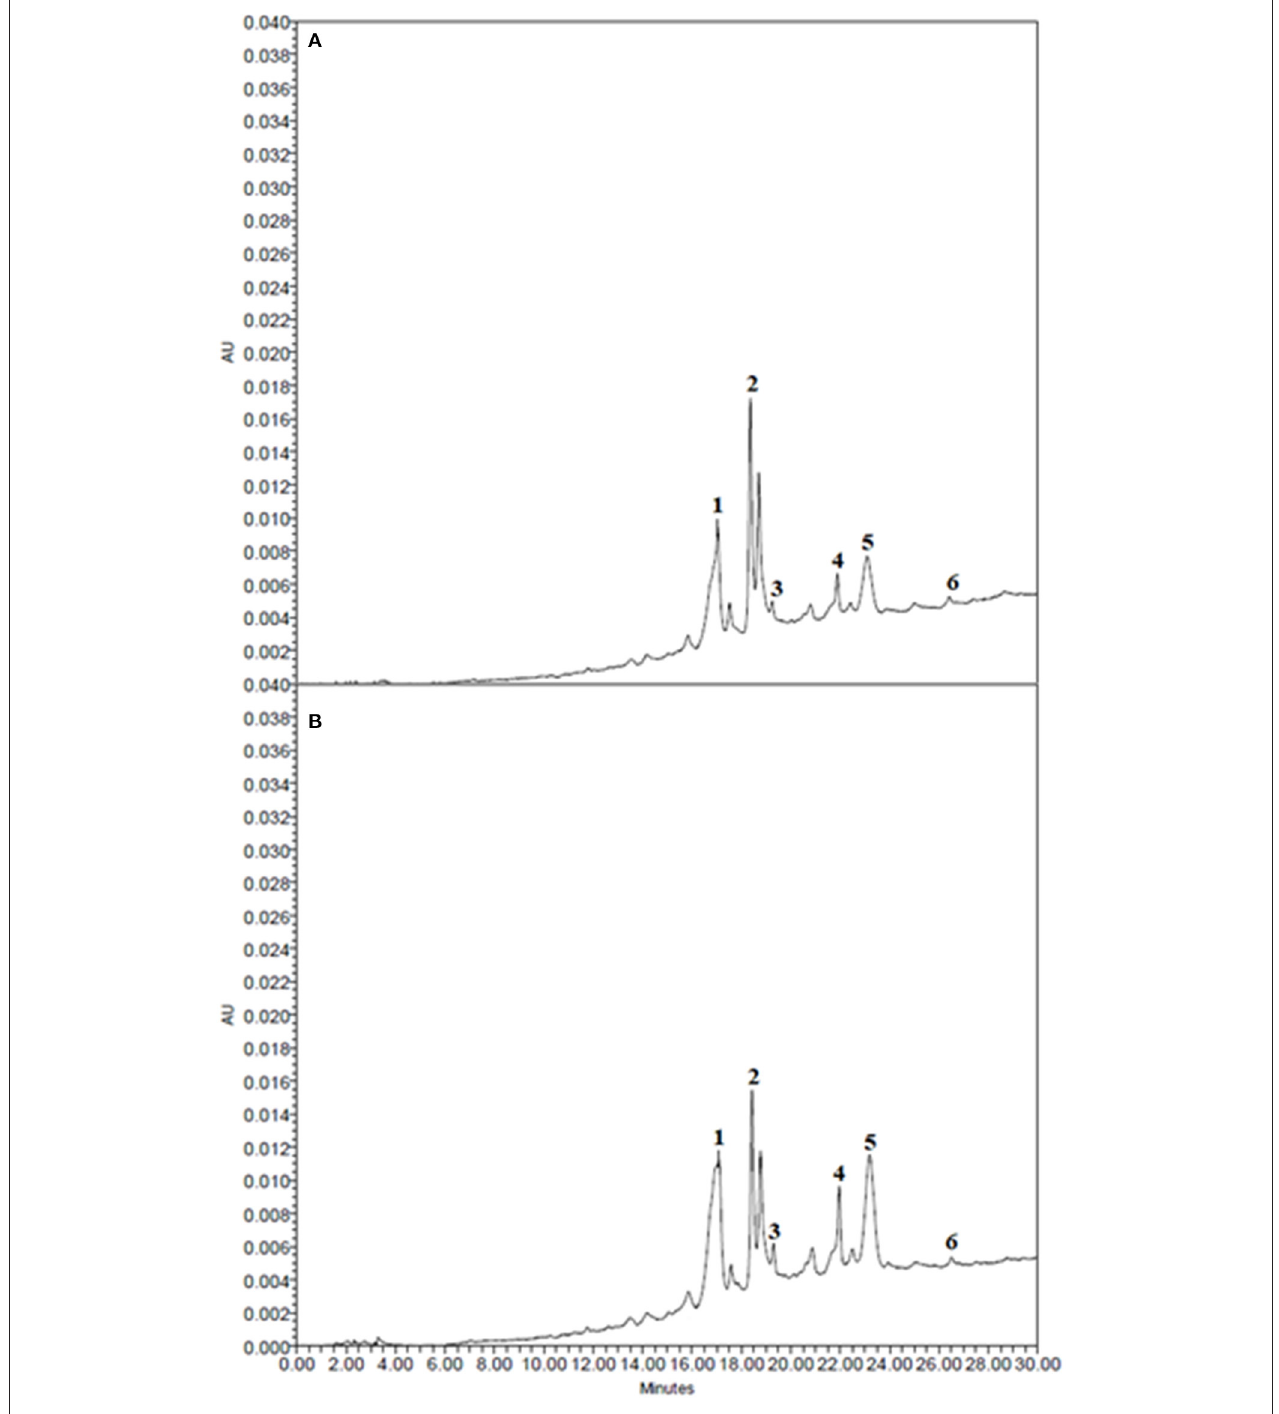
FIGURE 5 | HPLC-PDA chromatograms of 50% (v/v) ethanol-water extracts obtained after 190min of extraction at 50 ◦ C from (A) untreated (Control) and (B) PEF-treated (E opt = 3.8 kV/cm; W T,opt = 10kJ/kg) white grape pomace. Peak identification: epicatechin (1); unidentified compound (2); p-coumaric acid (3); unidentified compounds (4), and (5); quercetin